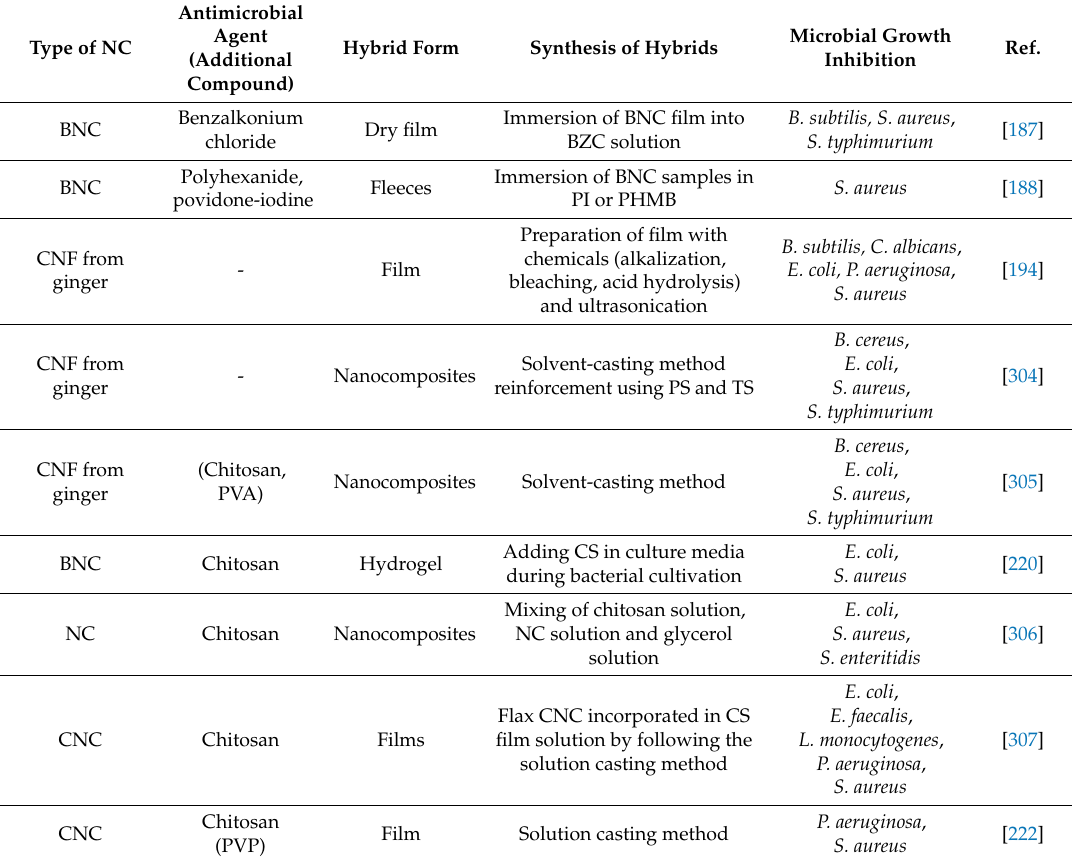
Table 5. Diverse organic NC-based antimicrobial